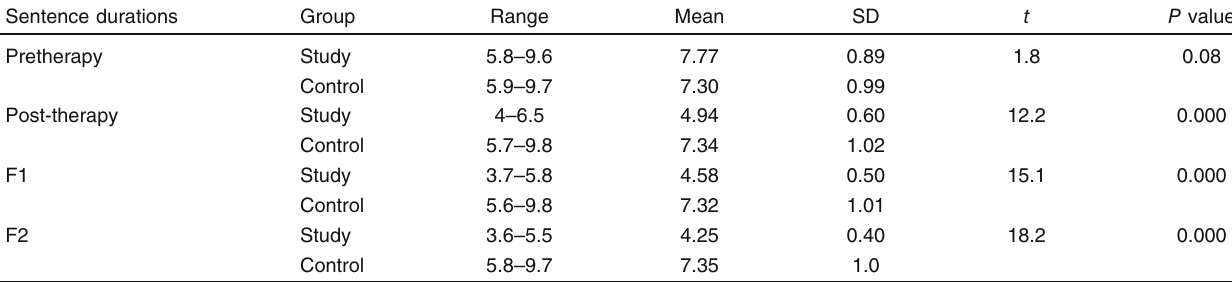
Table 6 Comparison between the control group and the study group as regards sentence duration Sentence